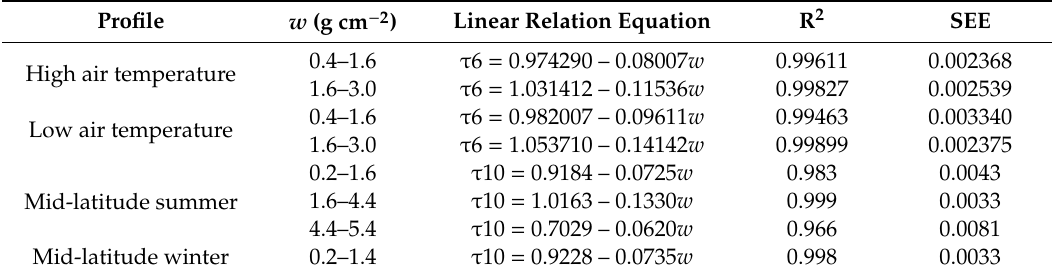
Table 5. The relation between atmospheric water vapor content and atmospheric transmittance